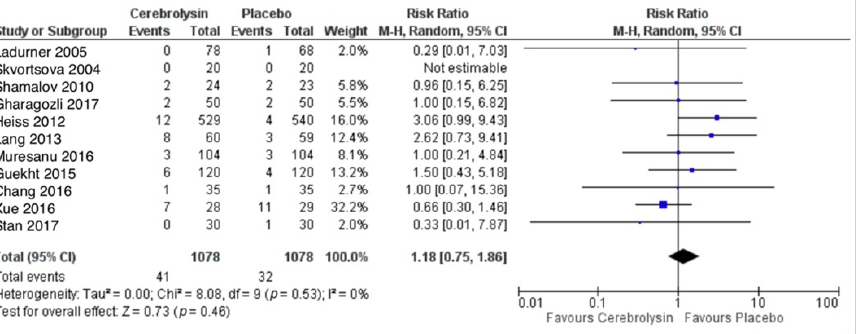
Figure 5. Non-fatal serious adverse events (patients with at least one NF-SAE); Comparison of Cere- brolysin versus Placebo in the Safety Population, Random Effects, M-H, Risk Ratio (RR).